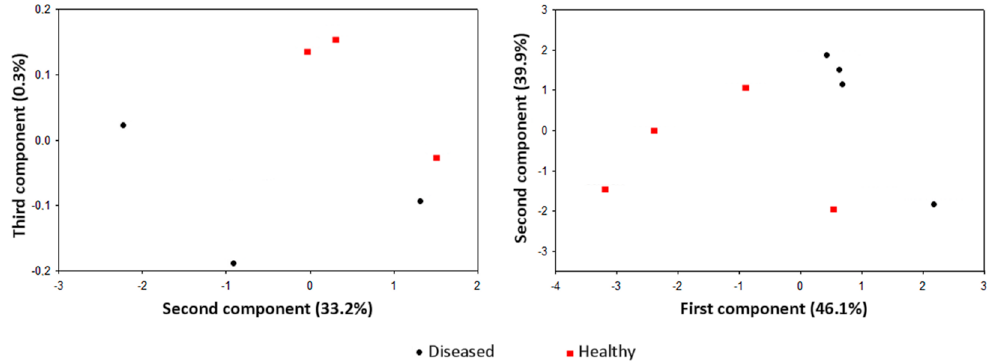
Figure 2. Score plot on the plane obtained with the second and third principal components of e-nose readings taken on healthy or E. amylovora -infected apple flowers (left panel) or detached branches (right panel), 3 days after inoculation. EOS835 e-nose was used with direct VOCs sampling. The discrimination of the two classes was not possible on the first component of total variance in flowers.